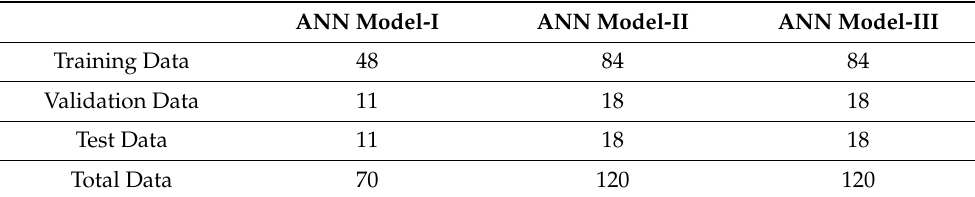
Table 2. Information about the data set used in the development of three different ANN